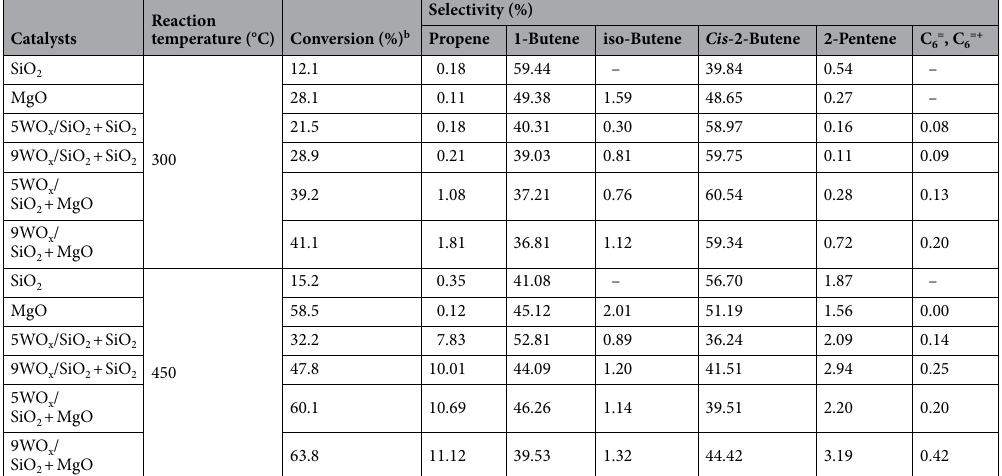
Table 2. Conversion and product selectivity of SiO 2 , MgO, WO x /SiO 2 + SiO 2 and WO x /SiO 2 + MgO catalysts of reaction temperature at 300° and 450 °C (WHSV = 0.21 h −1 ; P = 0.1 Mpa) a . a WHSV; weight of reactants were calculated from mixed reactant of 2% trans -2-butene and 4% ethene balanced in N 2 (P = 0.1 Mpa). b Conversion were calculated base on trans -2-butene